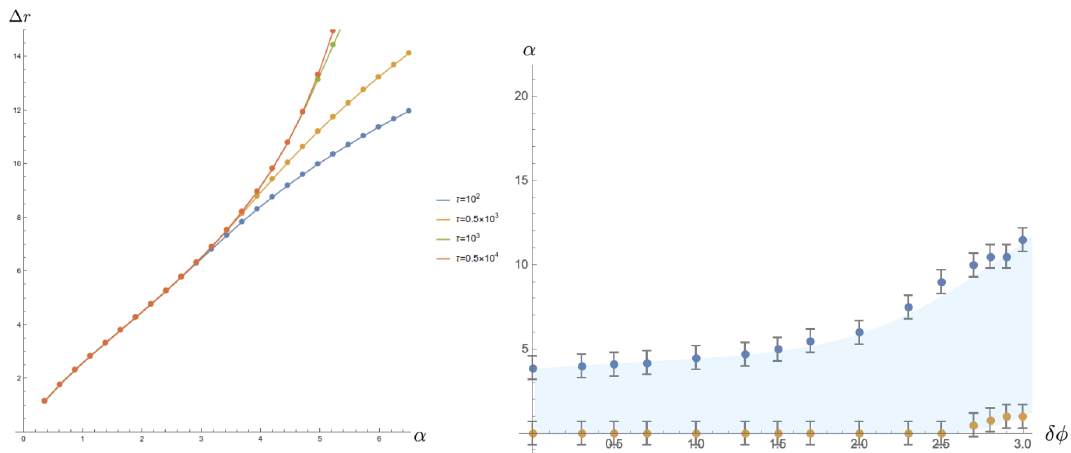
Figure 7 . On the left: for increasing relaxation time for δφ = 1 . 9 , ∆ r becomes arbitrarily large as α becomes larger than a critical value. On the right: the critical geometric ratio α crit = found to increase monotonically with the dilaton variation δφ across the